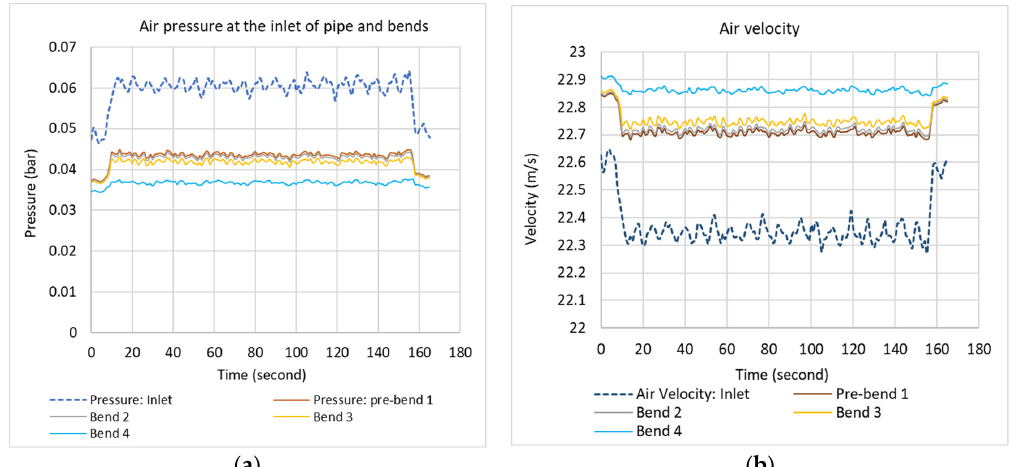
Figure 3. Measurement of localized particle velocity and average feed rate with 0.2 kg/s air flow rate and feeder speed of 5 RPM during conveying with bends in proximity; ( a ) Particle velocity at each bend, solid feed rate, ( b ) standard deviation in particle velocity measurement each second.